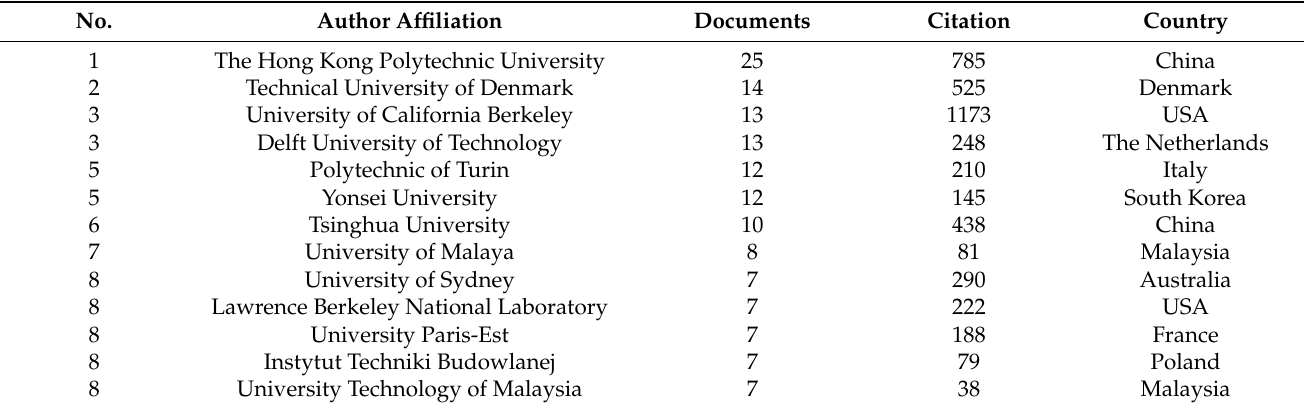
Table 3. Institutions that published the most on the IEQMI